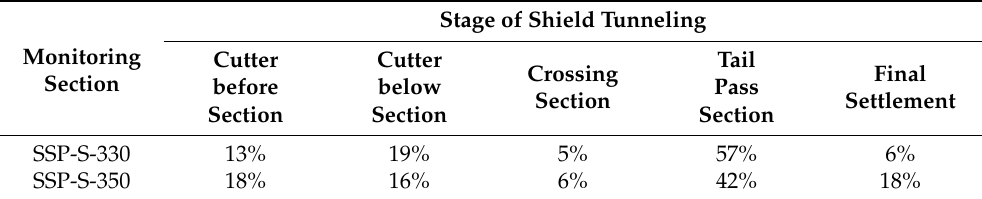
Table 3. Proportion of surface deformation during construction of the north line. Monitoring